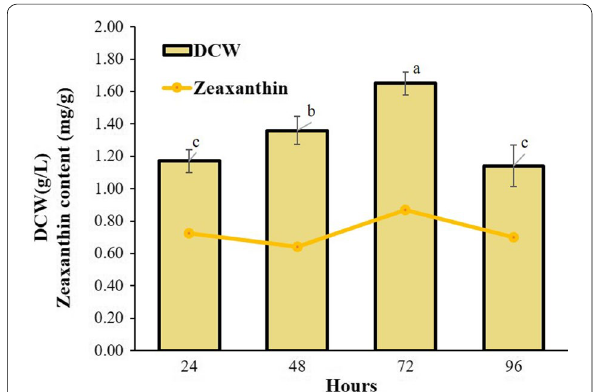
Fig. 3 Pattern of zeaxanthin accumulation and DCW in A.